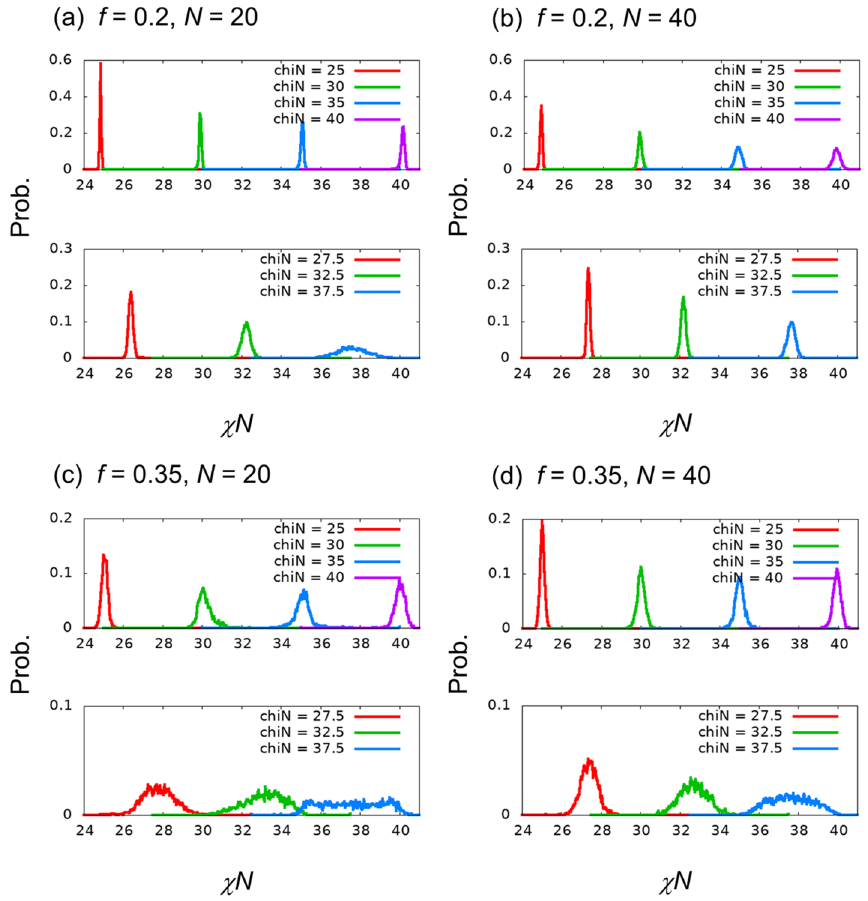
Figure 7. Probability distribution functions of the estimated χ N for evaluation data for the 4-class teaching images.